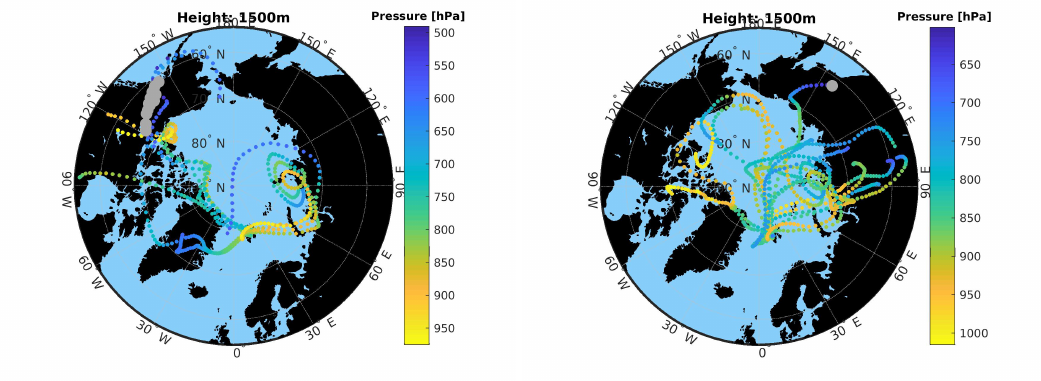
Figure 11. Five-day back-trajectories arriving at a 1500 m altitude over Zeppelin Station for days with “low AOD” (left) and “high AOD” (right) for April 2013. Thick grey dots mark areas with a relative humidity > 90% as an indication of hygroscopic growth of the